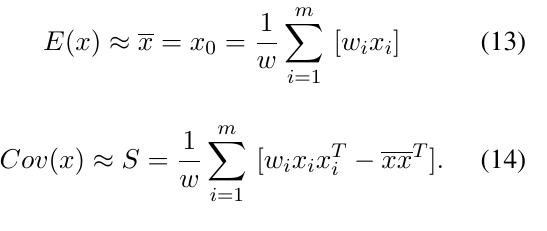
Supplementary Table 1.0 Showing Correlation coefficient of each Descriptor S/N